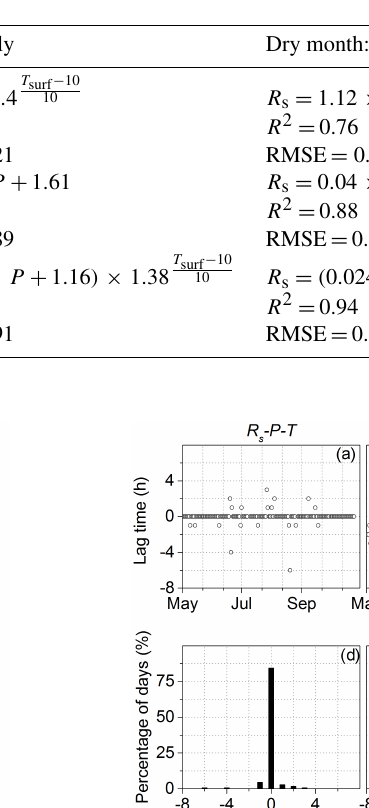
Table 2. Regressions based on the Q 10 , linear, and Q 10 -linear functions of soil respiration ( R s ) for both a wet (July) and dry month (August) in 2013. Variables T surf ( ◦ C) refers to the soil-surface temperature, P photosynthesis in the dominant shrub layer, R 2 the coefficient of determination, and RMSE the root-mean-square error.